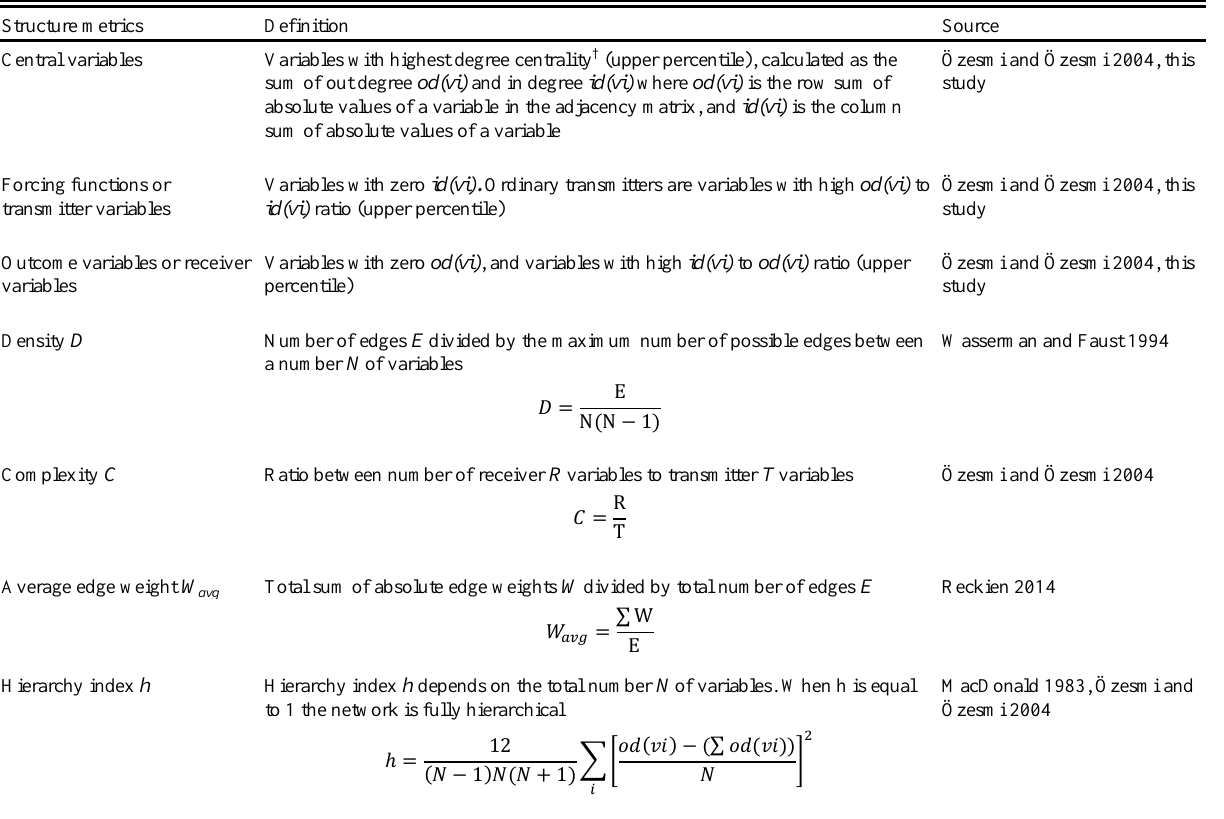
Table 1 . Indices for network structure analysis of the fuzzy cognitive maps (FCM).